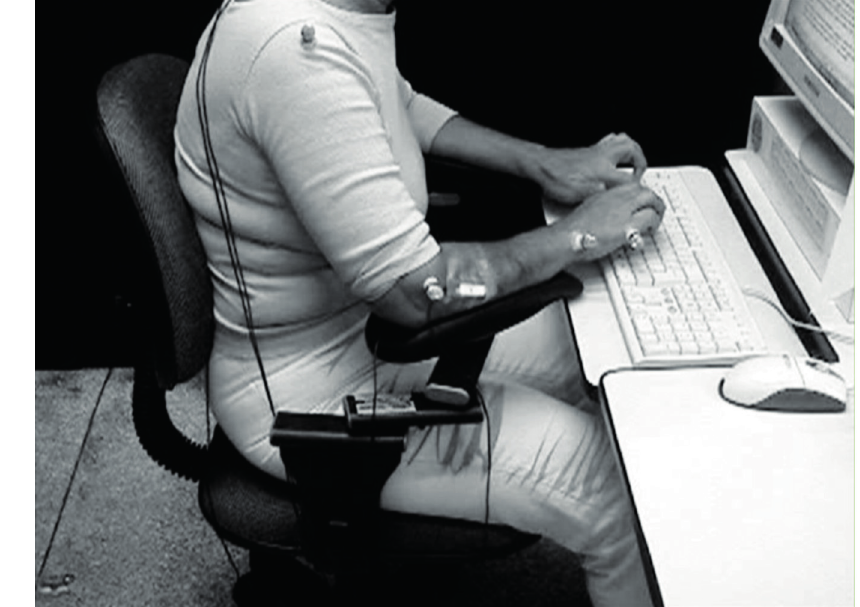
Figure 1 - Illustration of the typewriting activity during the trial with the developed arm support Source: Research